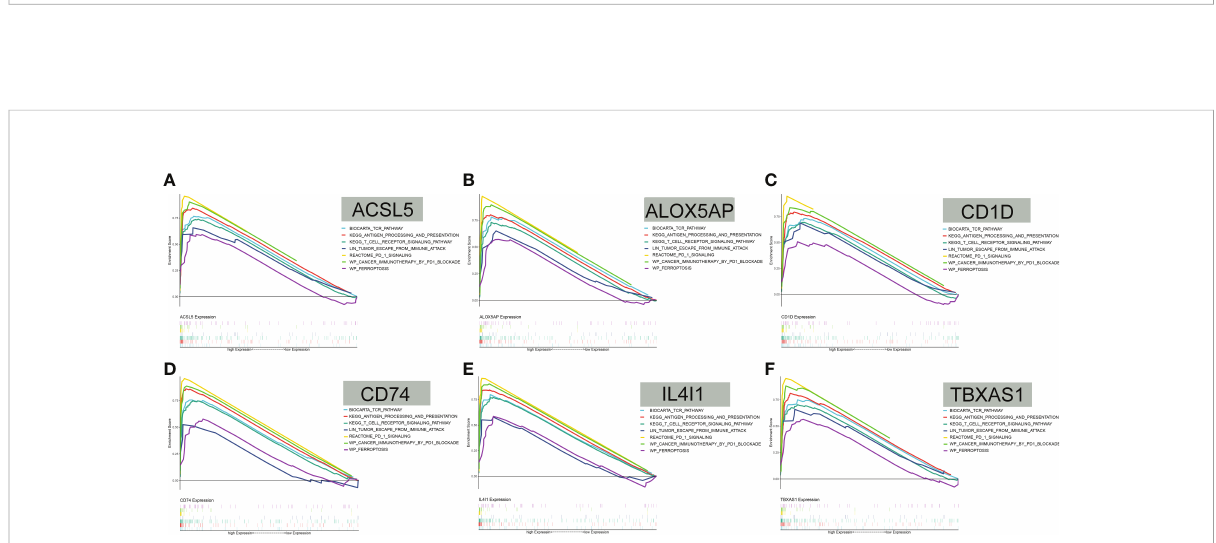
FIGURE 7 GSEA. (A – F) GSEA showed that antigen processing and presentation, T-cell receptor, the PD-1 signaling pathway, cancer immunotherapy by PD-1 blockade, tumor escape, and ferroptosis were all positively correlated with ACSL5, ALOX5AP, CD1D, CD74, IL4I1 , and TBXAS1 expression